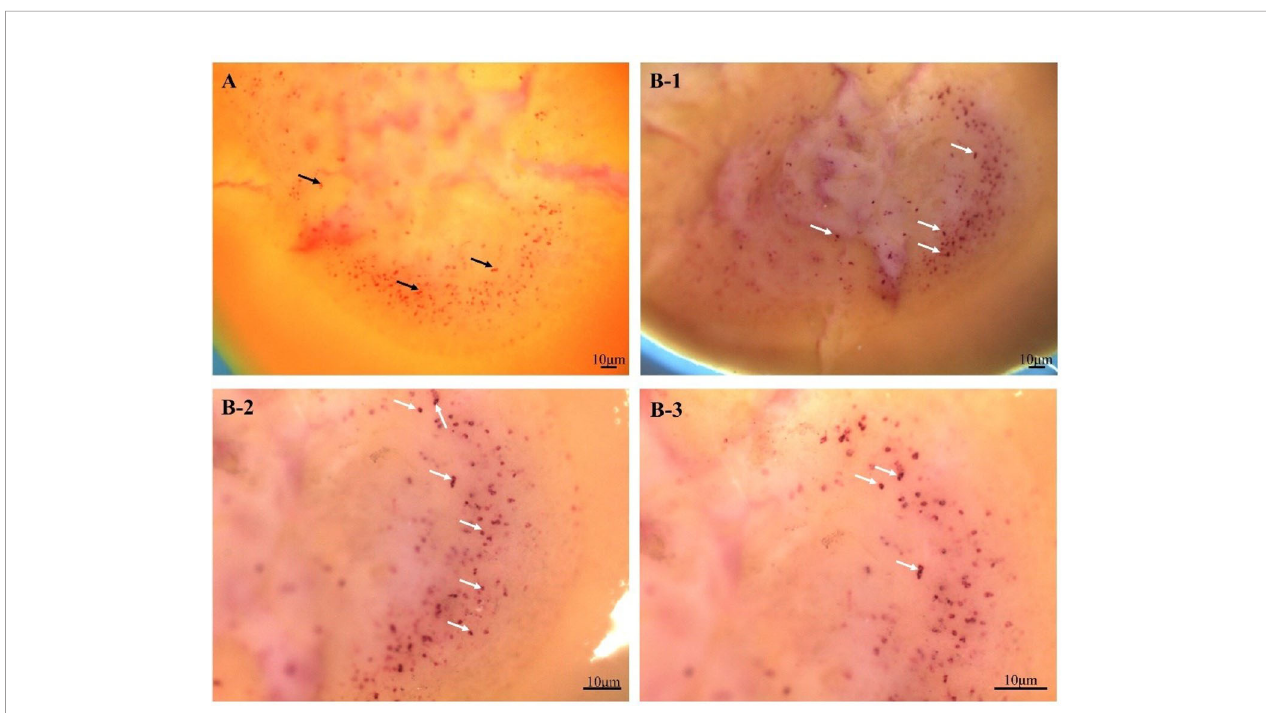
FIGURE 2 | Colocalization result of FMRFamide precursor and NOS in the optic lobe. (A) FMRFamide precursor localization on the optic lobe. (B) Colocalization of FMRFamide precursor (red) and NOS (purple) on the optic lobe. (A, B-1) The ventral area of the optic lobe connecting to the brain. (B-2/3) The dorsal area of the optic lobe connecting to the retina. The black arrows show some representative FMRFamide precursor positive signals; the white arrows indicate some representative colocalization sites of FMRFamide precursor and NOS. NOS, nitric oxide synthase.